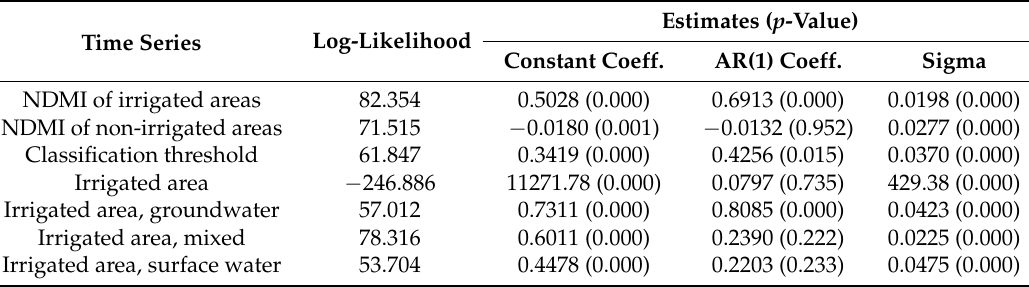
Table A4. AR(1) regression results, all time